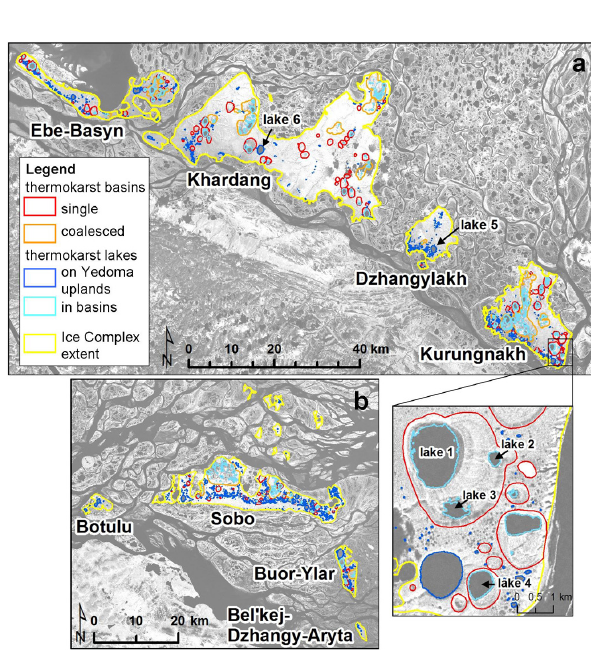
Fig. 4. Overview of study area with all thermokarst features inves- tigated: (a) western part, (b) eastern part. Landsat-7 ETM+ mosaic, band 4, GeoCover 2000, © NASA.